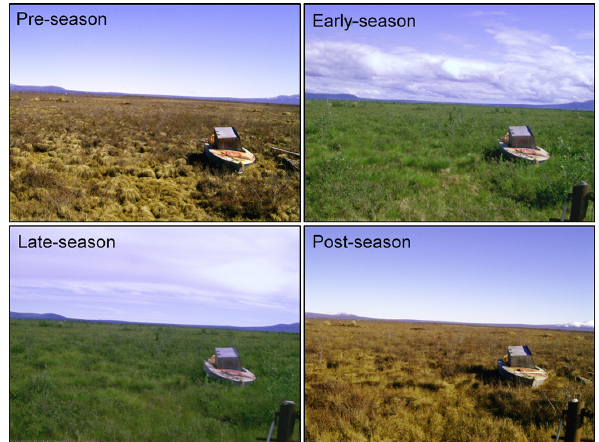
Figure 5. Cumulative CO 2 flux budgets for recent (2013–2015) eddy-covariance measurements for both sites (drained is in red, con- trol is blue). A grey line indicates the zero lines with a change from positive (i.e., release) and negative (i.e., uptake) fluxes. For these plots, timestamps have been normalized to account for interannual shifts in phenology. Time series were separated into the four differ- ent sub-seasons (see Sect. 2.6) using individual key dates for each year. Time series were then plotted in separate panels, resetting the budgets to zero at the beginning of each sub-season. No measure- ments are available for the 2013 pre- and early seasons, since mea- surements started mid-July